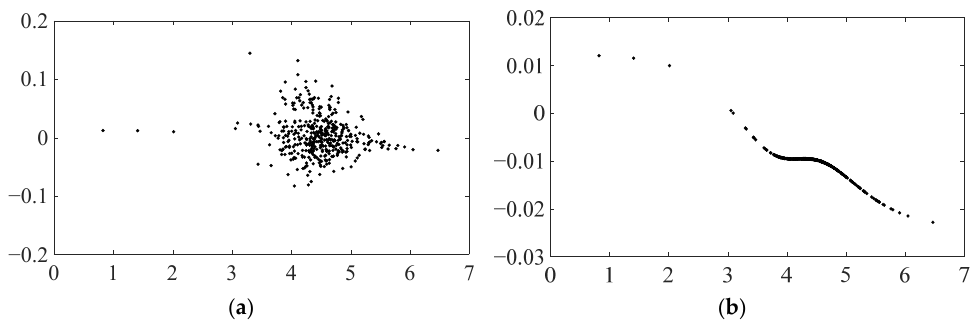
Figure 1. Nonlinear effects of EPU shocks on carbon emissions. Subplots ( a , b ) are a scatter plot and function plot, respectively.